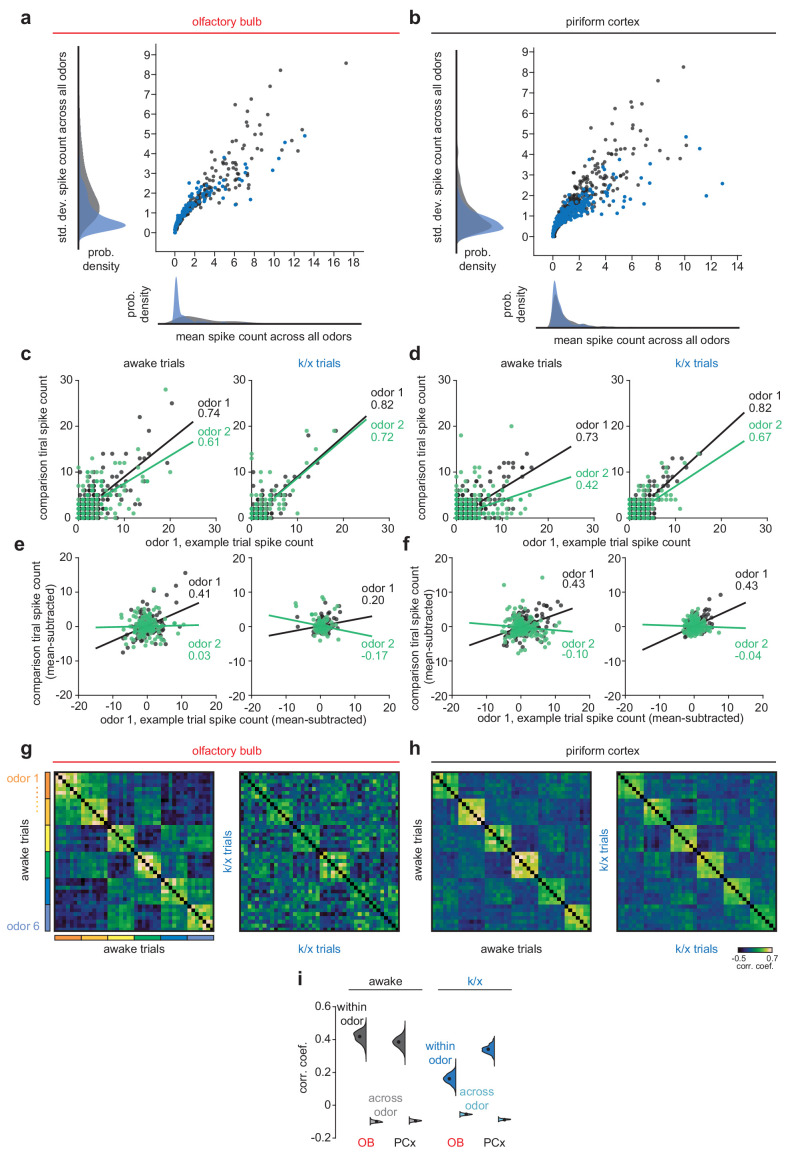
Trial-trial correlation changes after anesthesia reflect contributions of ‘background’ patterns and reduced reliability of OB odor responses.Increases in both within-odor and across-odor correlations observed in OB after anesthesia are not expected given a simple loss of OB responsivity. We therefore investigated the origins of increased OB correlations. Correlations could be driven by imposition of an odor-independent ‘background’ pattern that has a greater influence in anesthetized OB than awake OB or PCx in either state. (a–b) Scatterplot and histograms showing distributions of mean and standard deviation of spike counts across all odors in either state for OB (a) or PCx (b). Anesthetized OB (blue) has a large number of low-rate and low-s.d. responses, indicating a large portion of cells response weakly but very similarly to every trial of every odor. Including these responses in trial-trial comparisons can drive very large correlations within and across odors. (c–d) Illustration of trial-trial correlation calculation for one pair of within-odor trials (black) and one pair of across-odor trials (green) for raw spike counts without background subtraction in OB (c) and PCx (d). Correlation coefficients for these example trial-trial comparisons are indicated to the right of each linear fit line. Note small difference in within and across odor correlations in anesthetized OB. However, all correlations are large and positive, due to large numbers of consistently low-firing cells. (e–f) As in c-d, but for trial-trial comparisons after subtracting mean response across all odors within a state from each trial’s response. In this condition, across-odor correlations are often negative. (g–i) As in Figure 1j–l, but for background-subtracted population responses. After background subtraction, anesthetized OB tends to have weaker within-odor correlations than other conditions indicating reduced reliability of OB odor responses in this condition. Thus, after removing ‘background patterns’, OB responses remain degraded relative to PCx or awake OB responses.